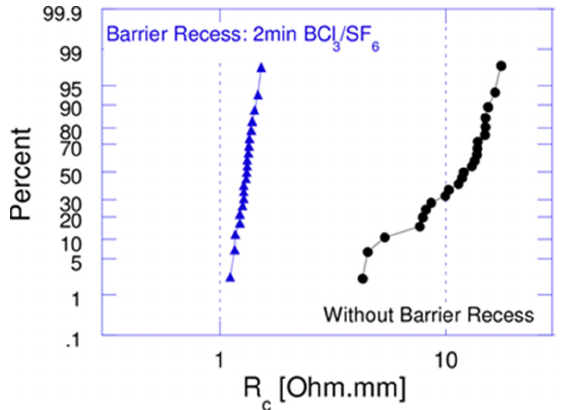
Figure 14. R C distributions of 200 mm GaN HEMT wafers with and without AlGaN barrier recess annealed at 550 °C [72] . Figure reproduced with permission from IEEE 2012 24th International Symposium on Power Semiconductor Devices and ICs.